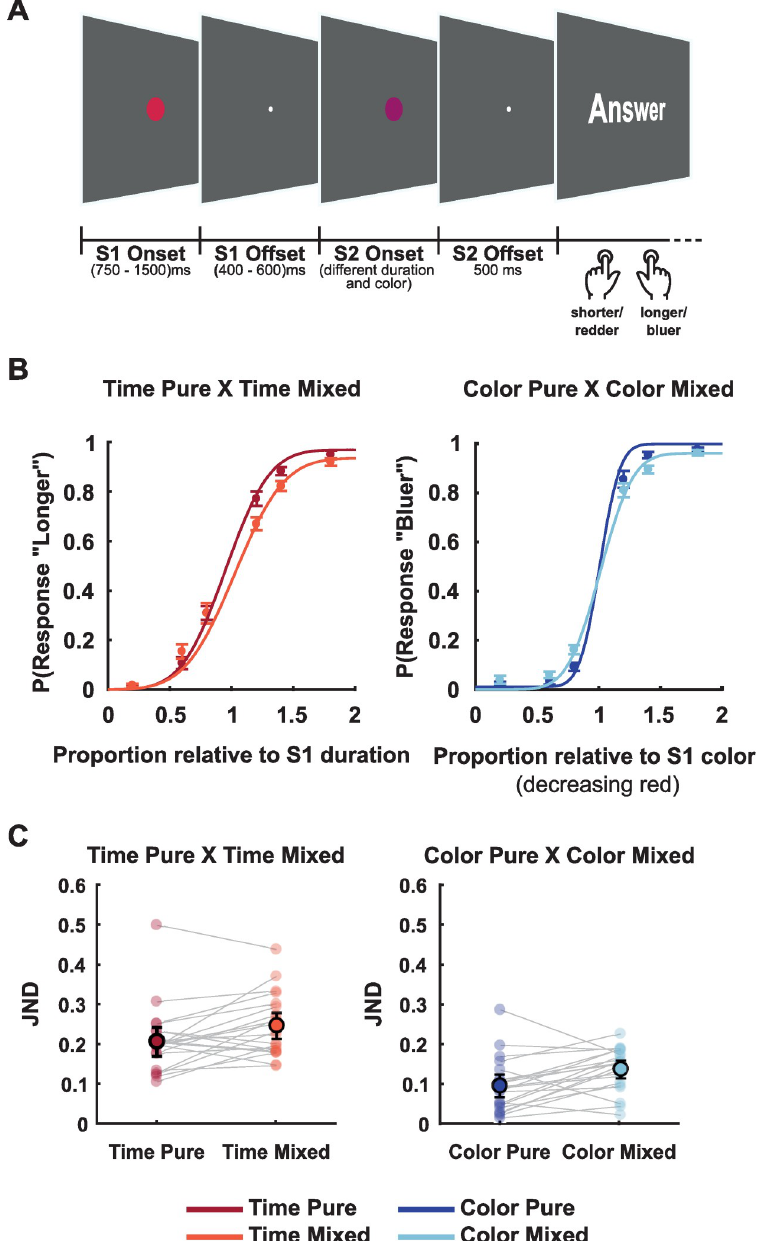
Fig 1. Experimental design and behavioral results. (A) Temporal/color discrimination task. The figure represents the time course of one trial. Before each block, a written cue would indicate if it was a ‘Time’ for Time Pure blocks, ‘Color’ for Color Pure blocks, or ‘Time/Color’ for Mixed blocks. (B) Curves show the psychometric functions for each condition, depicting the proportion of responding ‘longer’ for Time Pure and Time Mixed conditions (left) and responding ‘bluer’ for Color Pure and Color Mixed conditions (right). (C) Just Noticeable Difference (JND) by condition. Faint-colored filled circles represent individuals’ JND by condition. Lines connect JNDs for different conditions for each individual. Sharp-colored filled circles represent the mean JNDs, and bars represent the standard error of the mean.